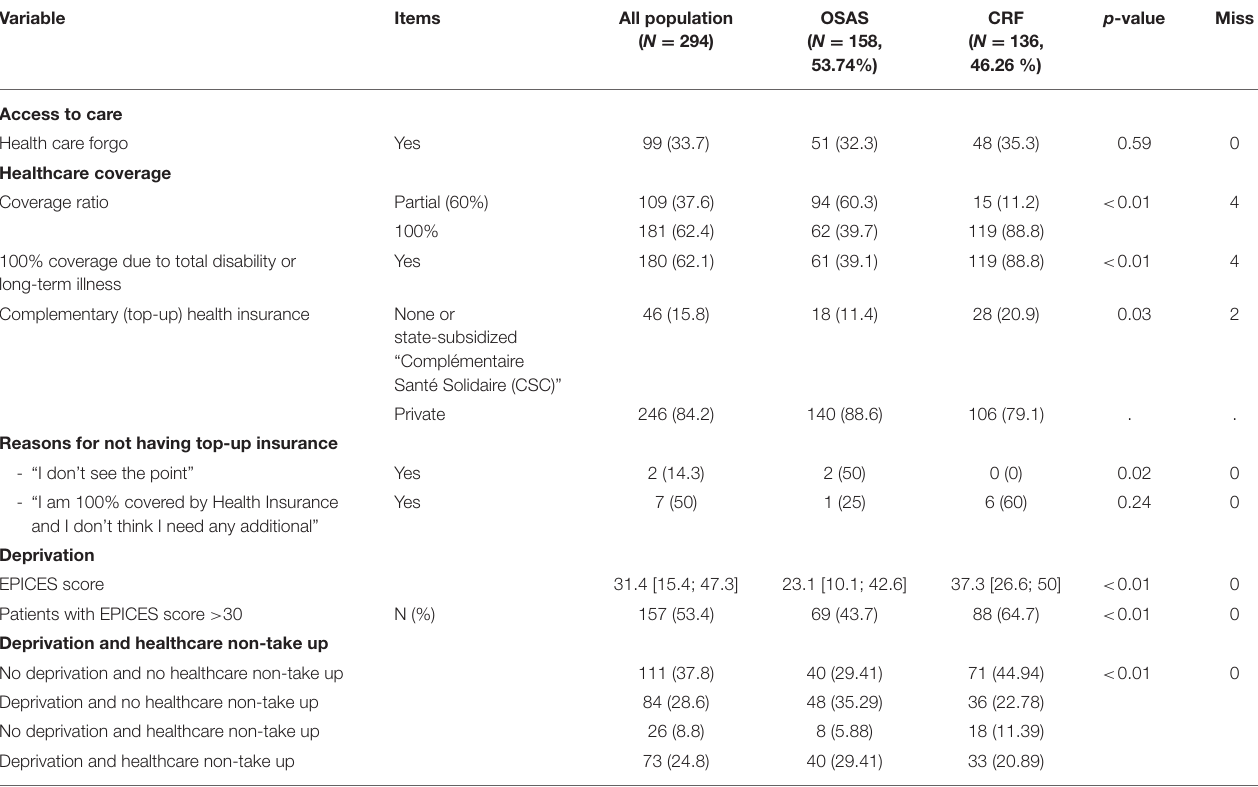
TABLE 2 | Access to care, healthcare coverage, and deprivation ( N = 294). Variable